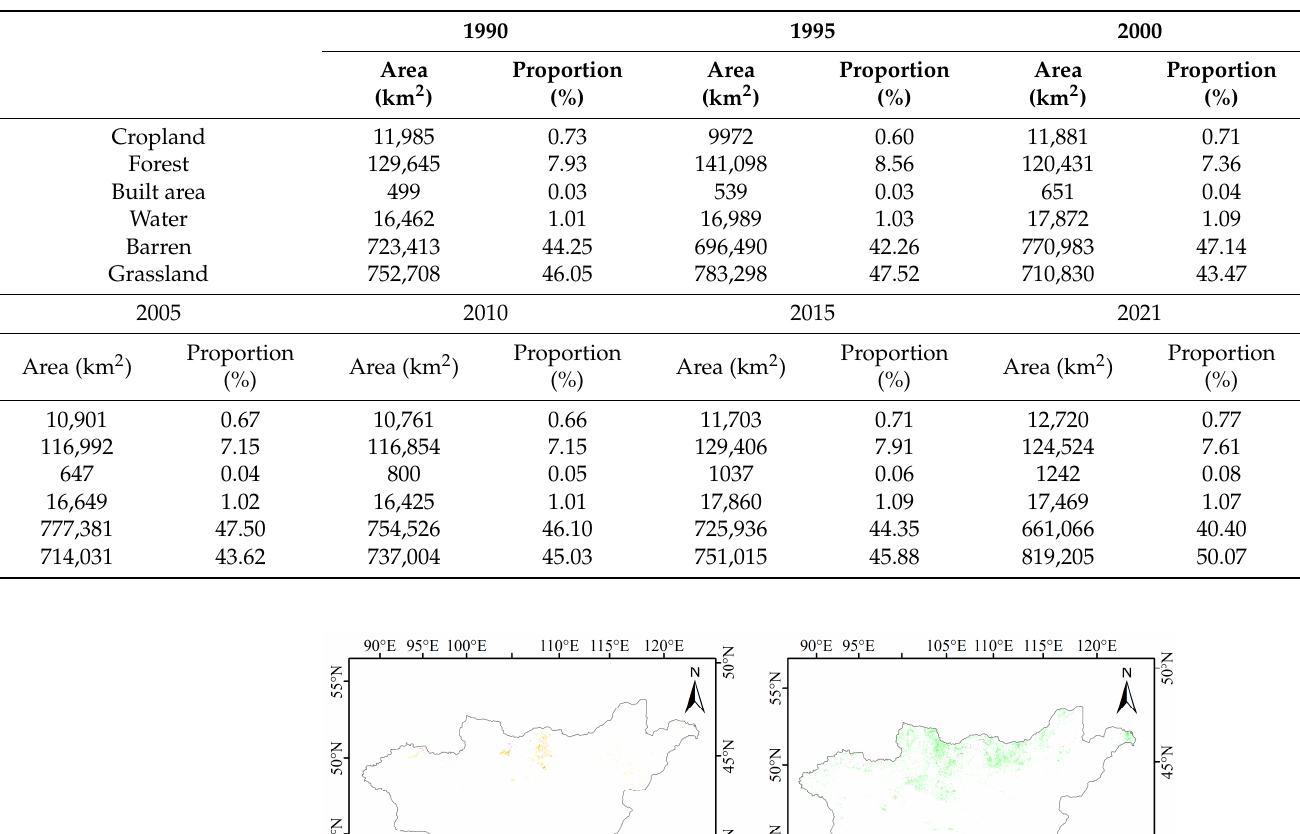
Table 3. The areas of different land use types in Mongolia from 1990 to 2021.